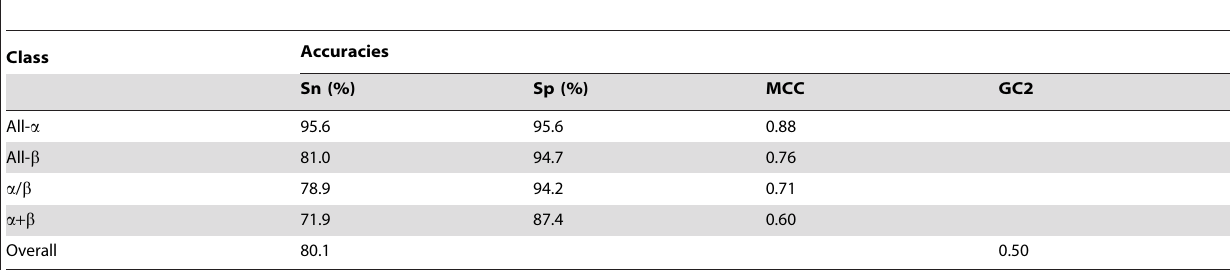
Table 2. Performance of the blind test using the independent D1185 dataset.